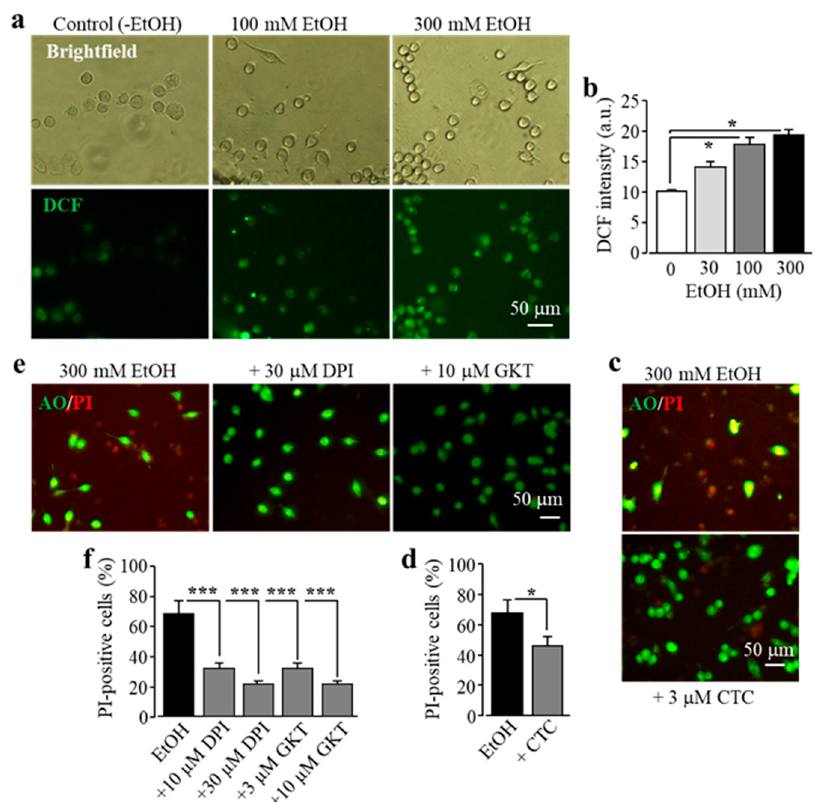
Figure 4. EtOH induces cell death in BV2 microglial cells via protein kinase C (PKC) and NOX-mediated ROS production. ( a , b ) Representative fluorescent images showing cellular ROS level (top row: brightfield in phase-contrast; bottom row: 2’,7’-dichlorofluorescein (DCF ) fluorescence) in microglial cells without (control) and with exposure to indicated concentrations of EtOH for 8 h ( a ), and mean DCF fluorescence intensity in microglial cells under indicated conditions from three independent experiments, using three wells of cells for each condition in each experiment. ( c – f ) Representative fluorescent images showing co-staining with PI and AO ( c , e ) and mean percentage of PI-positive cells ( d , f ) in cells without (control) and with exposure to indicated concentrations of EtOH for 8 h alone or together with chelerythrine chloride (CTC), diphenyleneiodonium (DPI), or GKT -137831 (GKT). Cells were pre-treated with the inhibitors 30 min prior to and during exposure to EtOH. Mean data are from three independent experiments, using three wells of cells for each condition in each experiment. * p < 0.05; *** p < 0.005 compared to indicated control group.